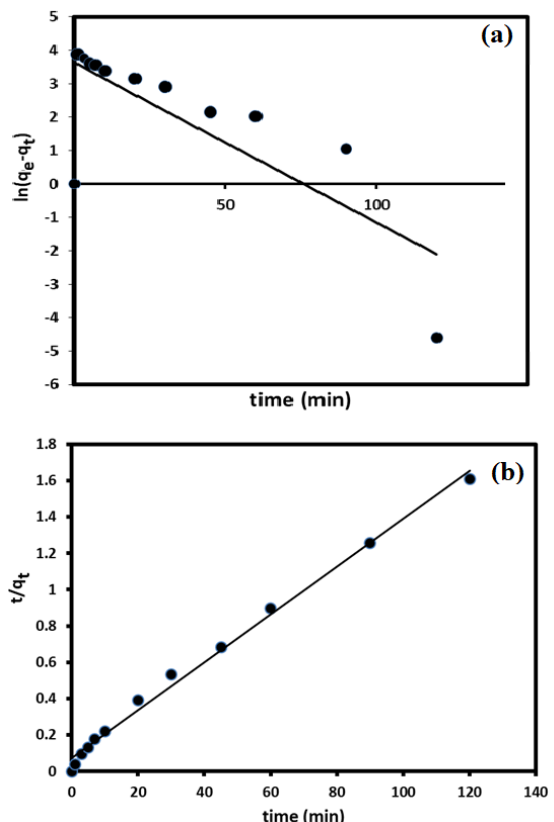
Figure 12. Pseudo ‐ first ‐ order kinetic model plot ( a ) and pseudo ‐ second ‐ order kinetic model plot ( b ) for DV31 dye removal from an aqueous solution by G CuO NPs. (Experimental conditions: DV31 concentration 25 mg/L; 1 mL H 2 O 2 ; sample volume 200 mL; 20.0 mg CuO NPs; pH 8.6 and temperature at 25 °C).